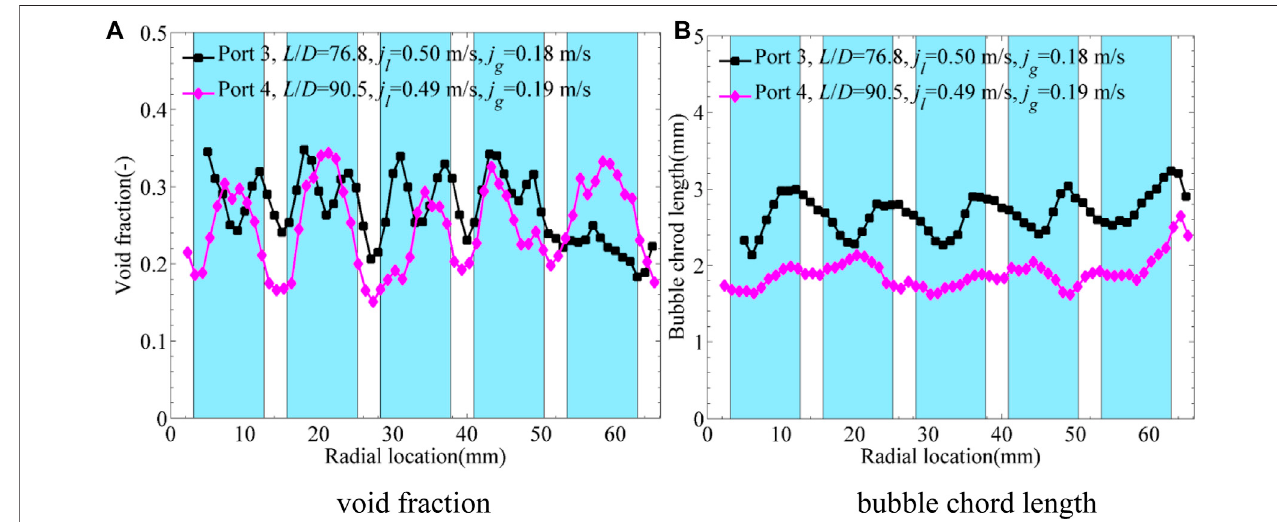
FIGURE 11 | In fl uence of MVSG on transitional phase distribution. (A) Void fraction. (B) Bubble chord length.